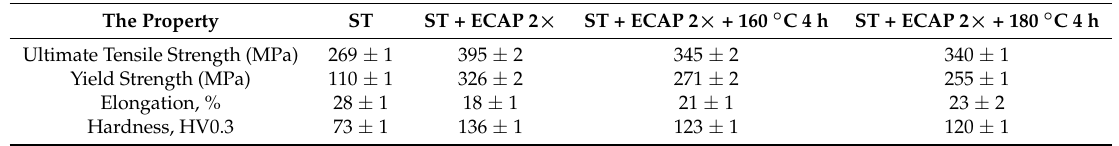
Table 4. Mechanical properties of AlMg5 alloy before and after ECAP processing.